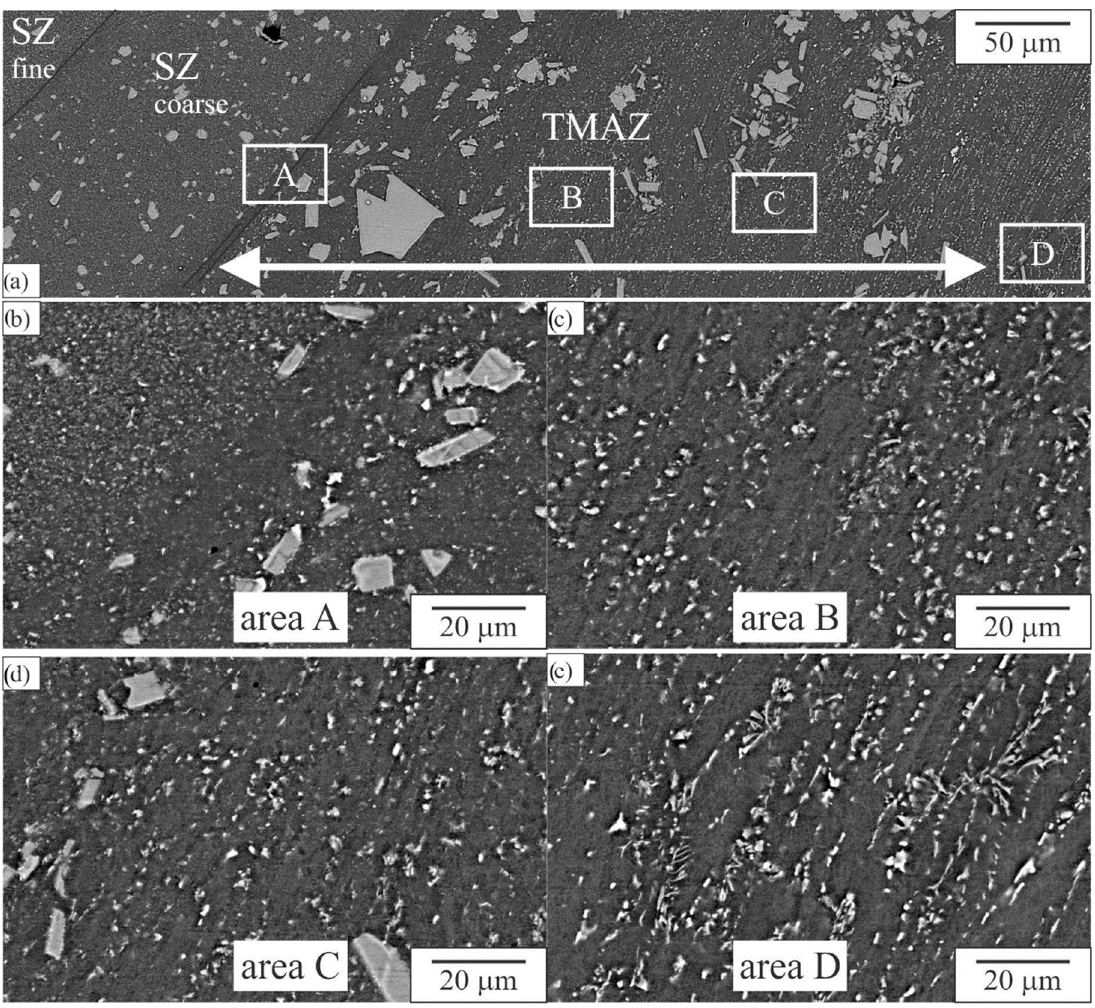
Figure 13. Transition from SZ to HAZ of the advancing side of sample FSP950 (within the area T-AS in Figure 2). ( a ) Composed image of the transition. ( b – e ) Enlarged images of the areas indicated in ( a ).